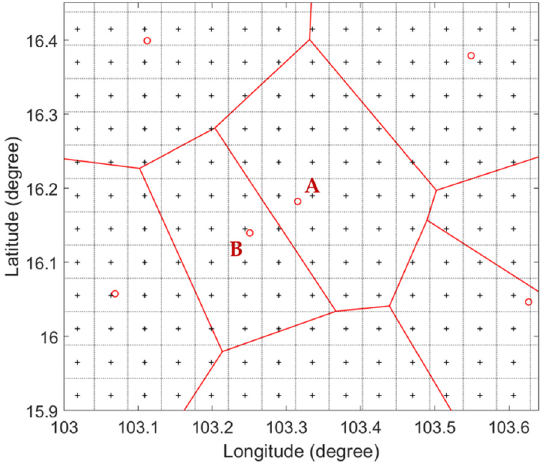
Figure 4. Serving areas of substation A and substation B created by using the Voronoi diagram.